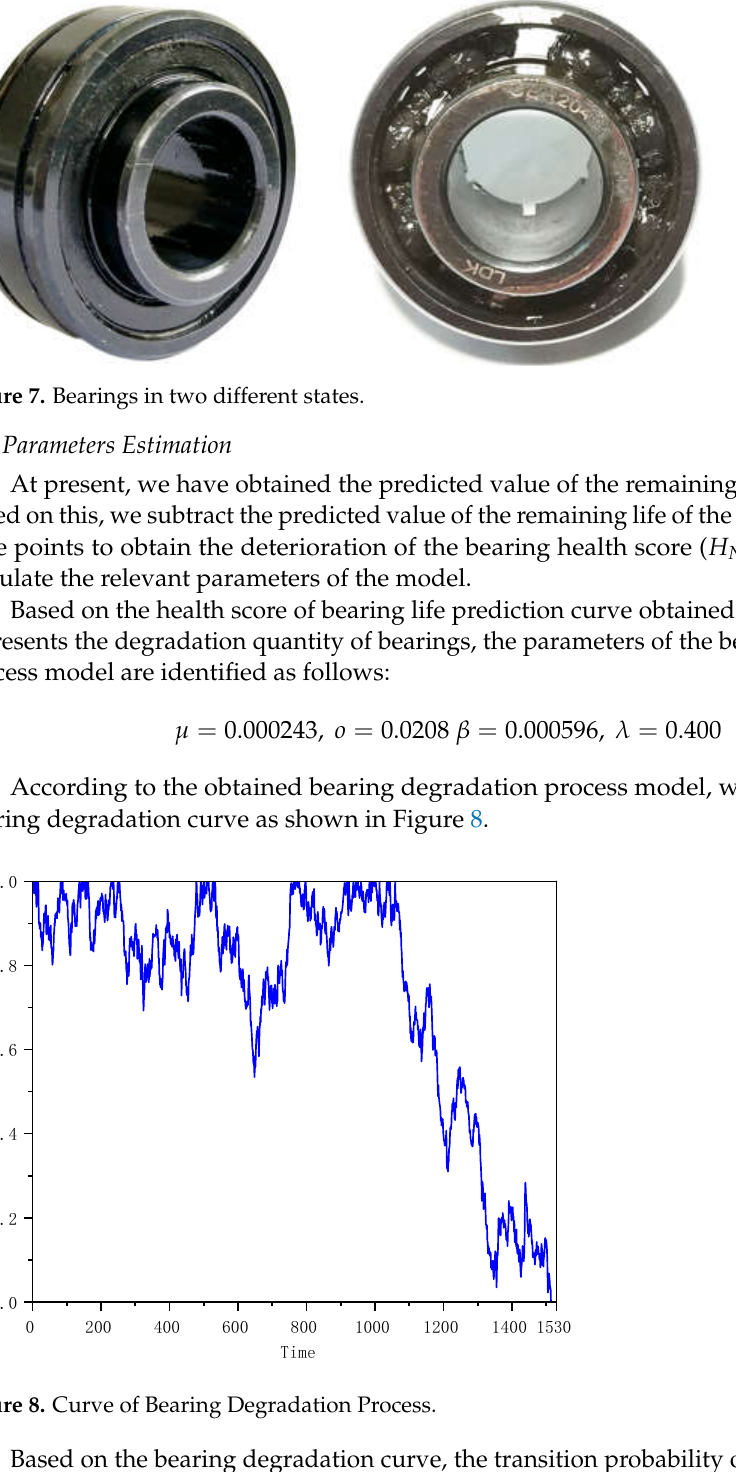
Figure 6. Bearing life prediction curve.